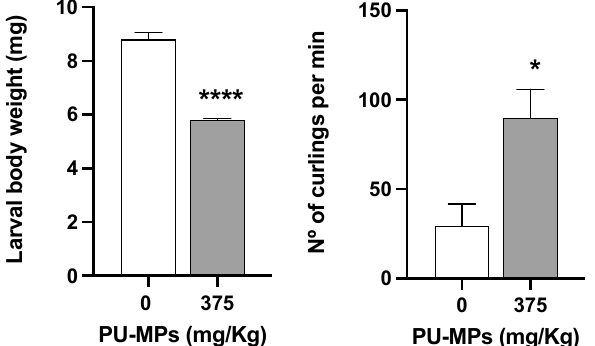
Figure 4. Effects of polyurethane microplastics (PU-MPs) in Chironomus riparius larval weight (left side; n = 5) and larvae locomotion (number of curlings and uncurlings per minute; right side; n = 4), after 10 days of exposure. All values are presented as mean ± standard error of the mean. *, **** denotes a significant difference from the control with p < 0.05 and p < 0.0001, respectively.